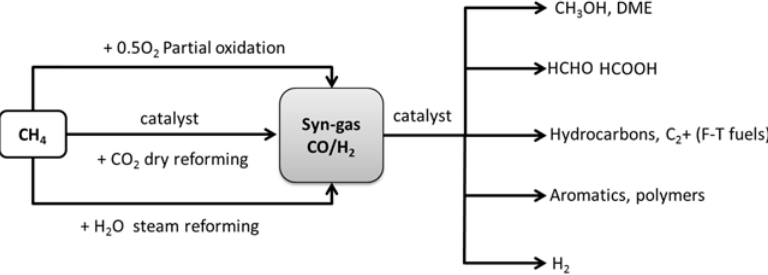
Figure 1. Indirect methane conversion to produce fuels and value-added chemicals via intermediate syngas